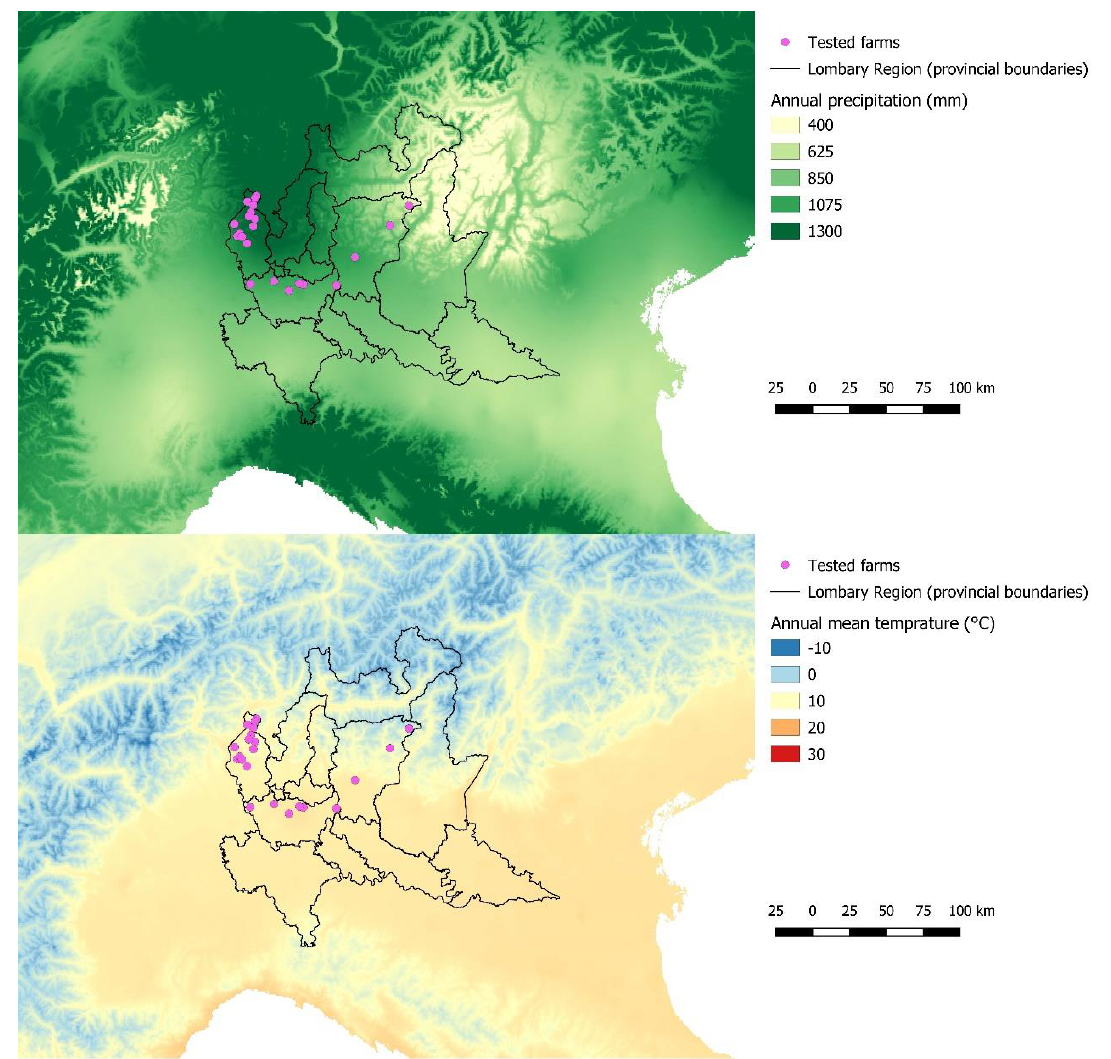
Figure 1. Spatial distribution of surveyed small ruminant farms in the study area according to temperature (upper) and rainfall maps (lower).